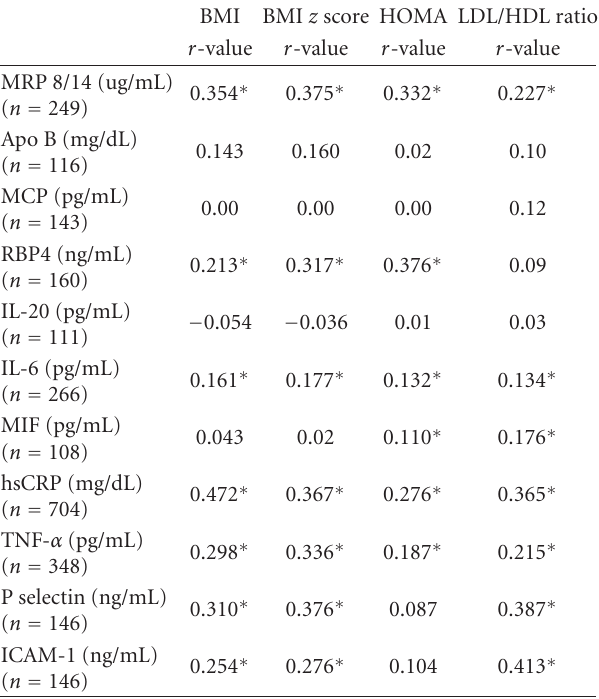
Table 3: Correlation coe ffi cients between BMI and BMI z score and plasma levels of several inflammatory markers in